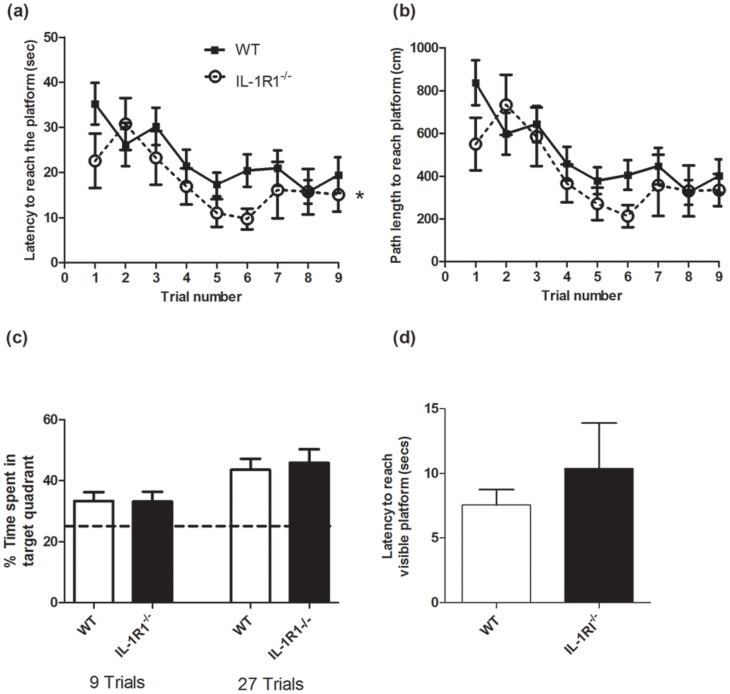
Spatial and non-spatial memory in the Morris water maze in IL-1R1−/− and WT mice.(a) The latency to reach the hidden platform, and (b) the path length were assessed in IL-1R1−/− mice (n = 11) and WT mice (n = 20) in the spatial memory water maze task across 9 trials with 1 hour inter trial interval. (c) Probe trials performed after 9 trials and 27 trials (dotted line shows 25%), and (d) non-spatial memory (flag trial) in IL-1R1−/− mice and WT. Data are expressed as mean±SEM and were analysed by two-way repeated-measures ANOVA with strain as between subjects factor and time as within subjects factor (a, b) or by t-test (c, d). * denotes main effect of strain (p = 0.02).